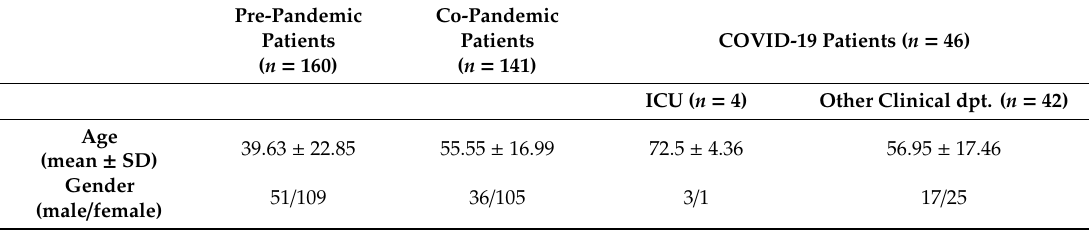
Table 1. Details of pre-pandemic, mid-pandemic, and COVID-19 patients samples used in this study.